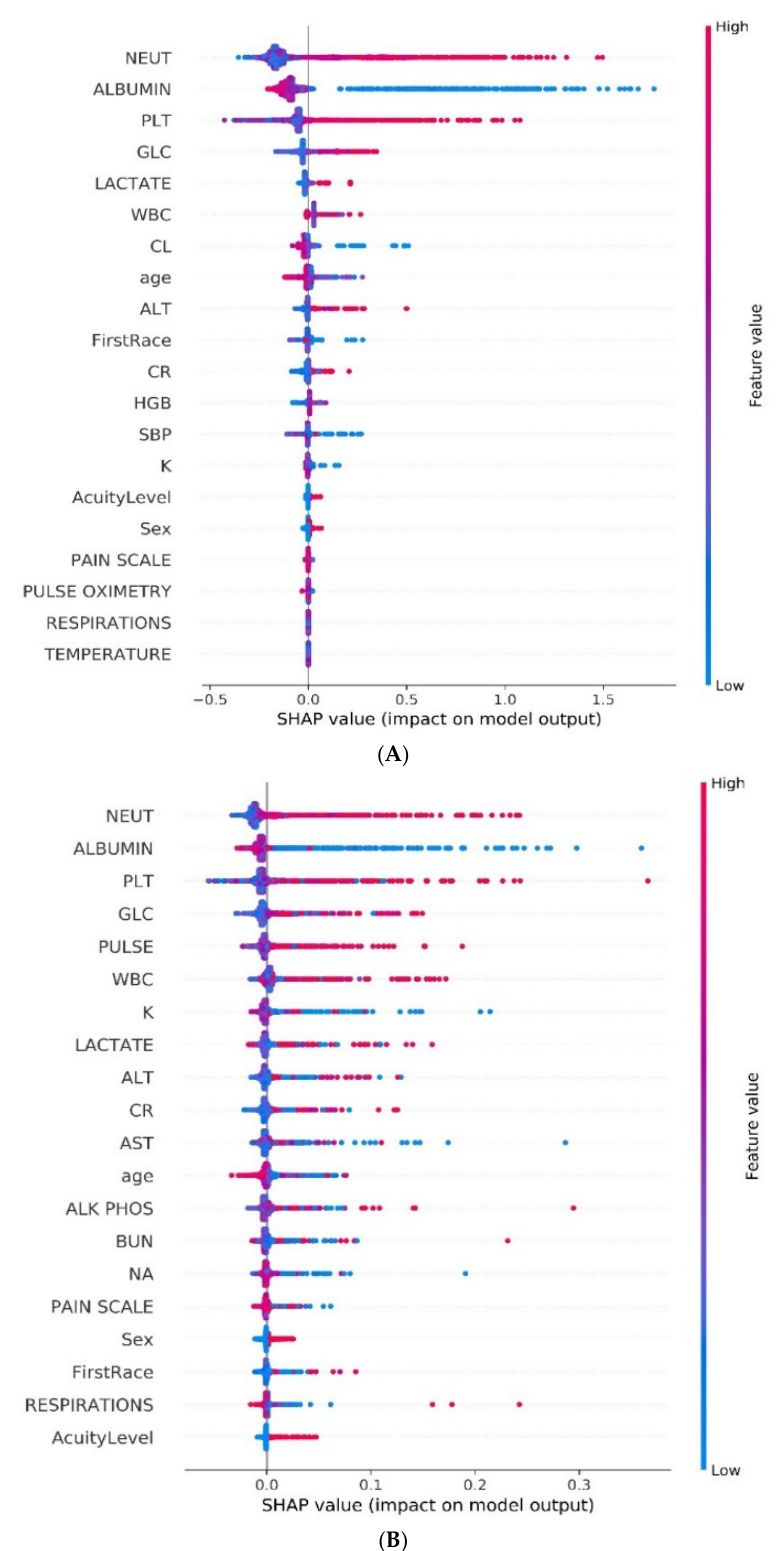
Figure 3. ( A , B ) SHAP explainability plots of the final gradient-boosting and random forest models. For Youden’s index, the final GB model showed a sensitivity of 88% with FPR 1:3.6 (Table